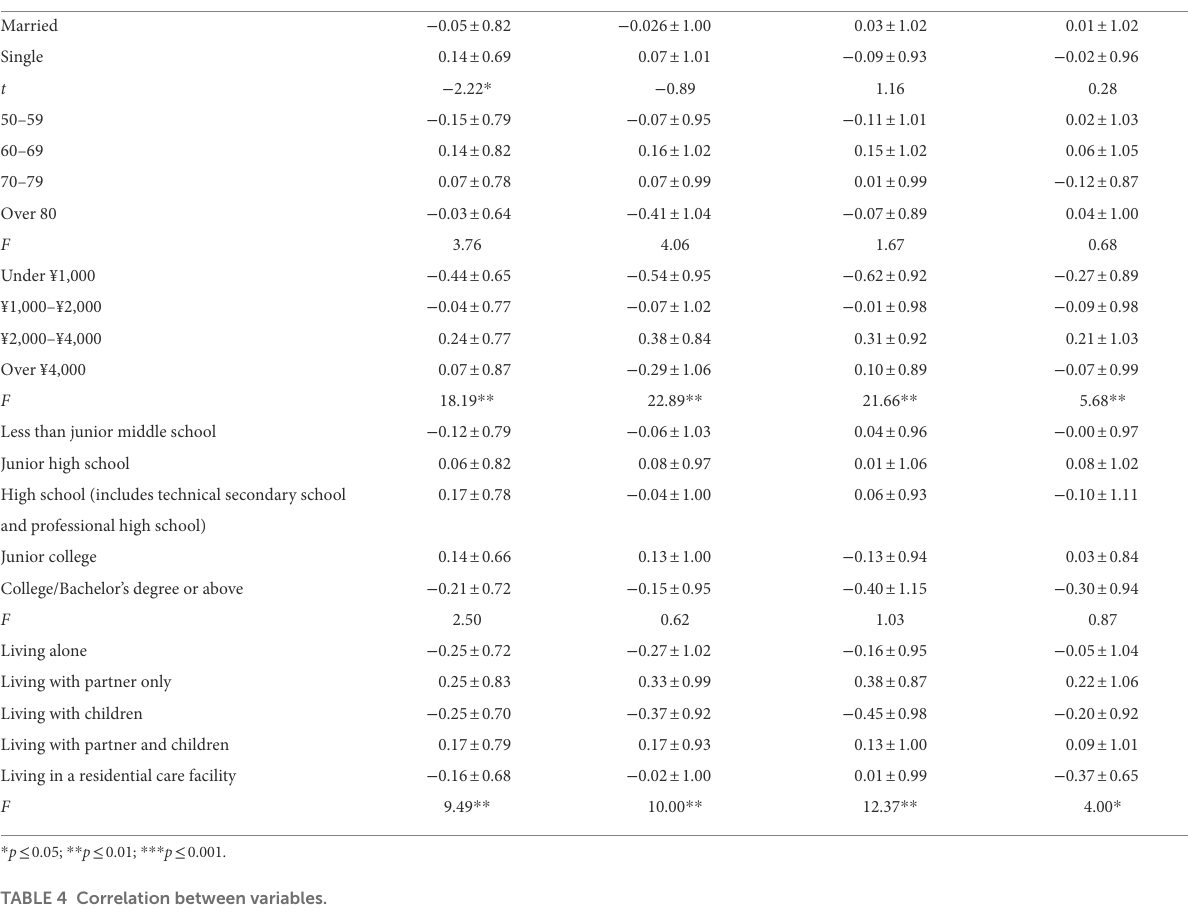
TABLE 3 Descriptive analysis.